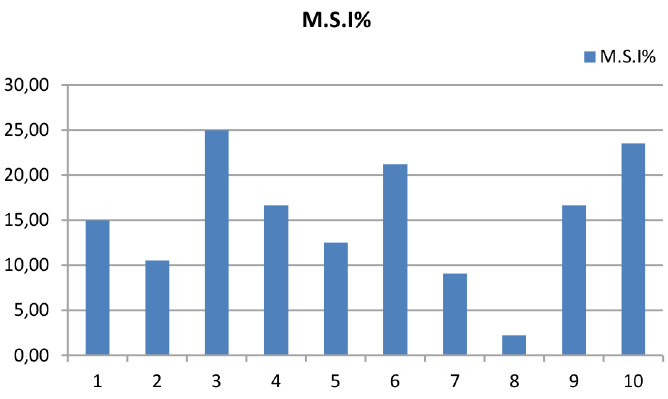
Figure 56. Makespan index graph for the solved experiments